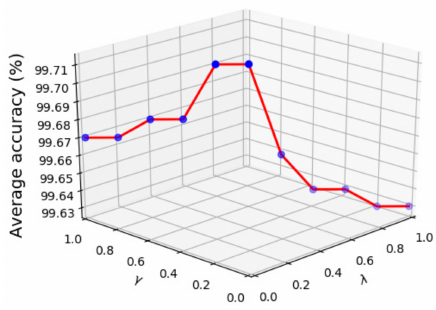
Figure 16. The relationship between average accuracy and parameters λ , γ .